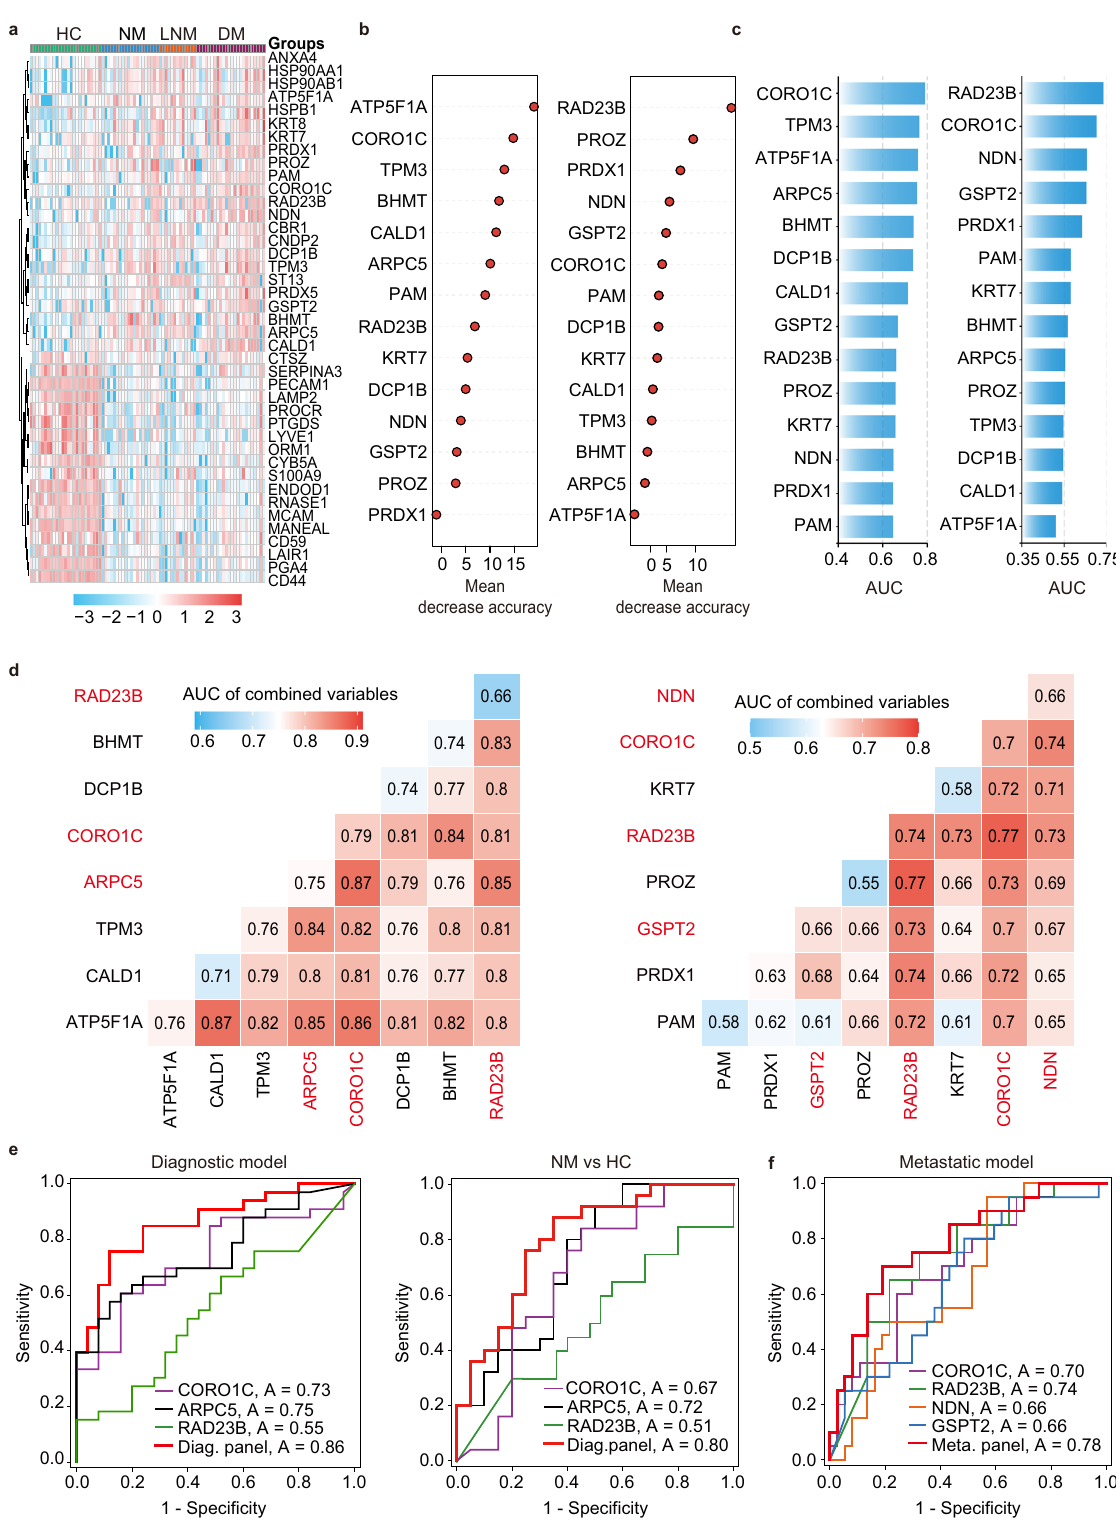
protein. In addition, the panels in both models can complement FIT or serum CEA to provide better